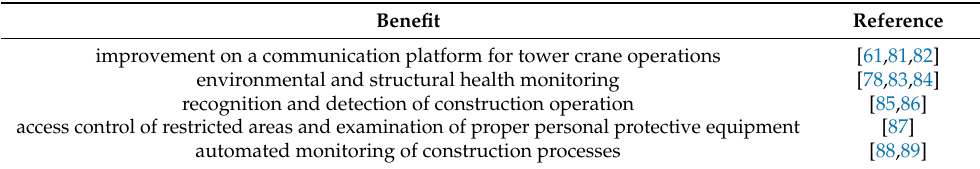
Table 3. Wireless sensor networks in construction safety